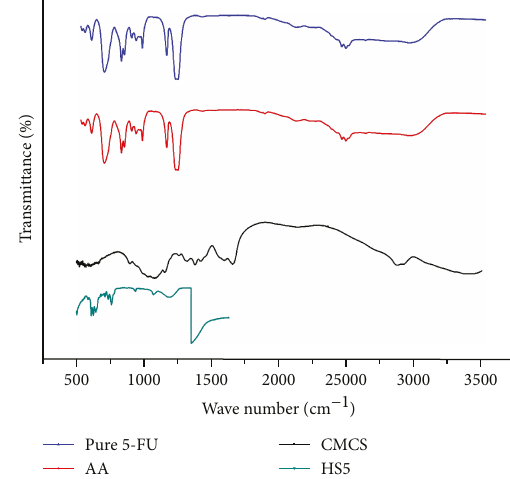
Figure 10: FTIR spectra of (A) 5-FU, (B) AA, (C) CMCS, and (D) Poly (CMCS- g -AA) hydrogel